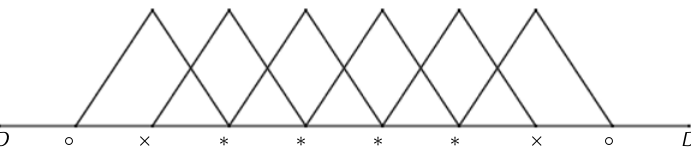
Figure 1. Domain decomposition between Ω FEM and Ω FDM in one dimension. The interior nodes of the unstructured finite element grid are denoted by stars, while circles and crosses denote nodes, which are shared between meshes in Ω interior nodes ω of the grid in Ω , while the crosses are interior nodes ω x of the grid in Ω 0 FDM obtained in Ω at ω is copied to the corresponding nodes in Ω FDM 0 to the corresponding nodes in Ω FDM